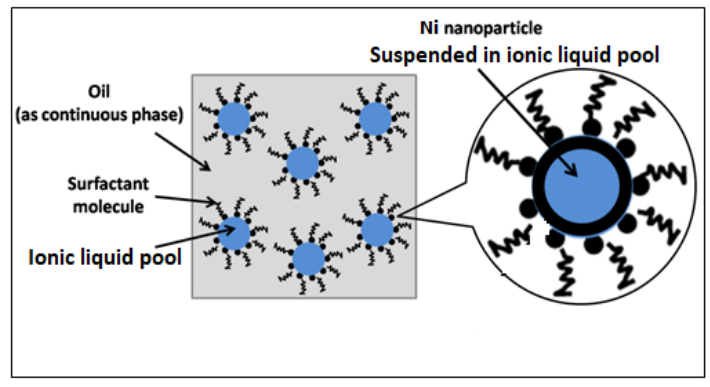
Figure 1. Microemulsion synthetic route of Ni-NP preparation.